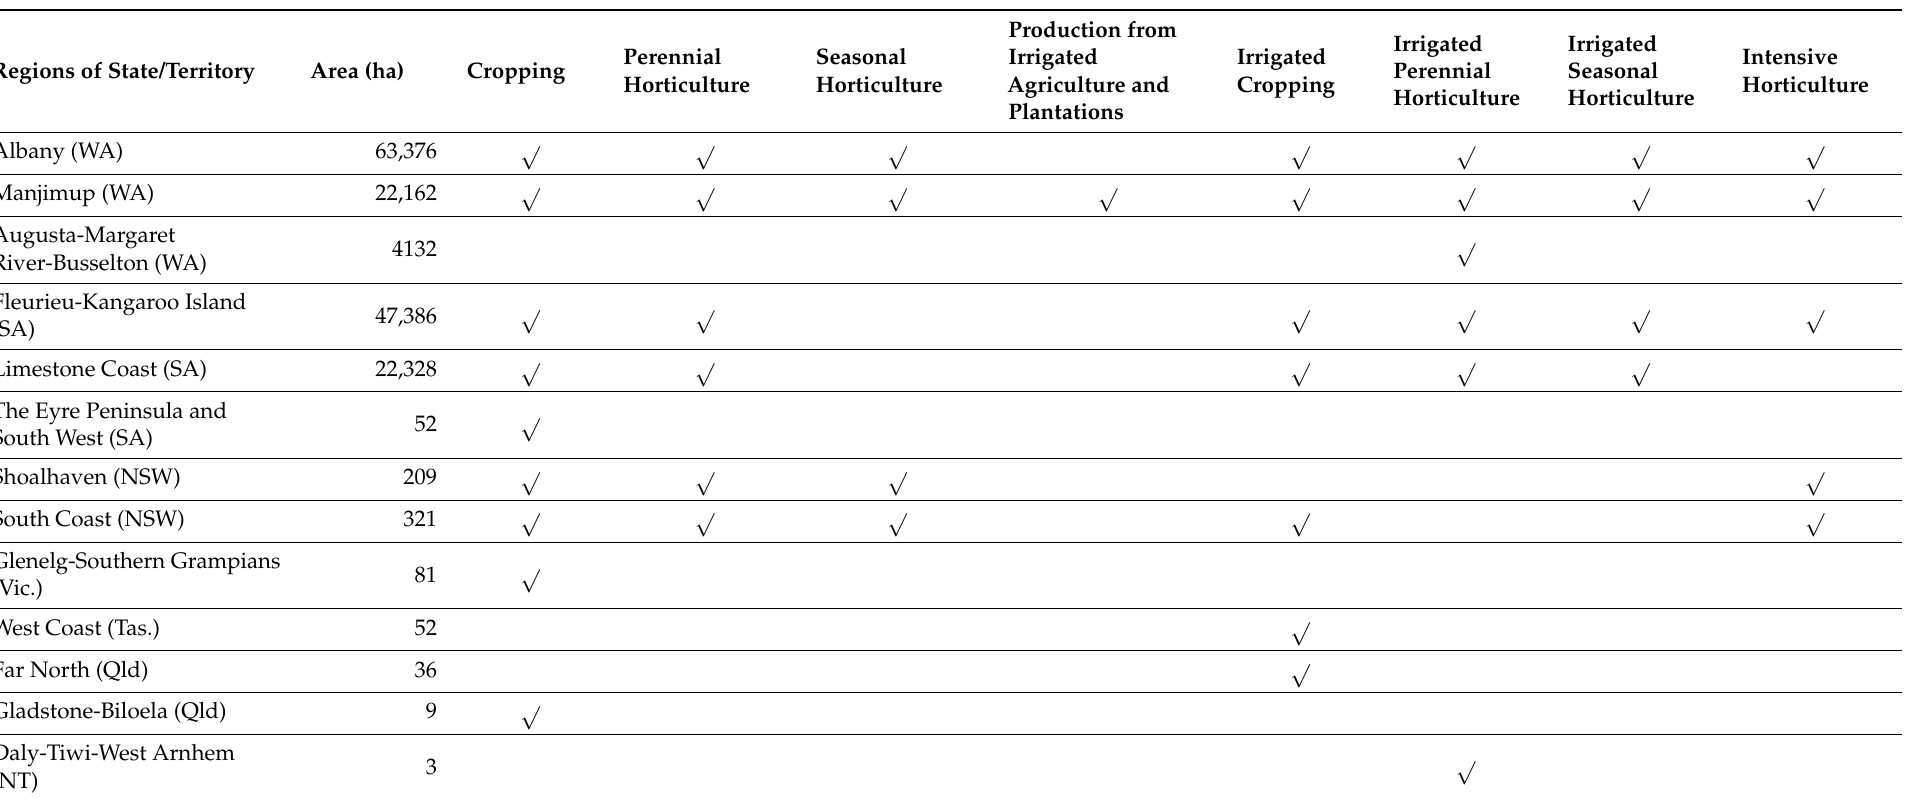
Table 3. Types of cultivation located in different regions of Australia that show potentially high suitability for Thaumatotibia leucotreta